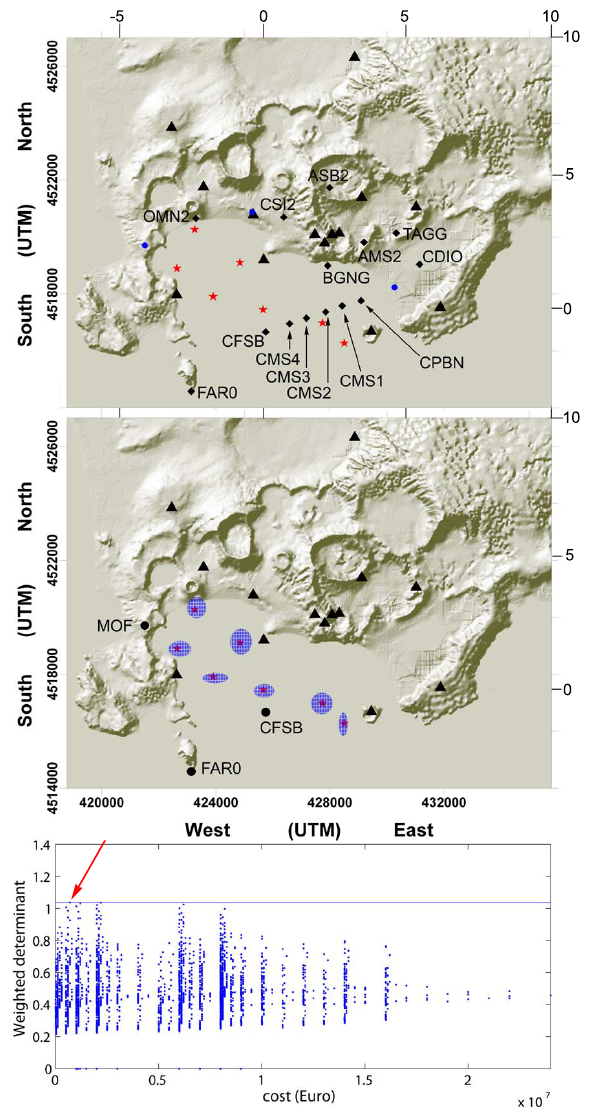
Fig. 3. Results of the optimization analysis performed considering the sites shown by black diamonds and blue ball in panel a and de- scribed in Table 1. Black triangle show the stations of the permanent seismic network. The blue circles indicate the position of the 3 wells where 5 station depths are considered (DRI, WEL and MOF). Panel (b) shows the result obtained by choosing the 3 stations (among 29 possible ones, black diamond) that would optimally improve the present network of Campi Flegrei (black triangles) for the location of the 7 earthquakes indicated by the red stars and listed in Table